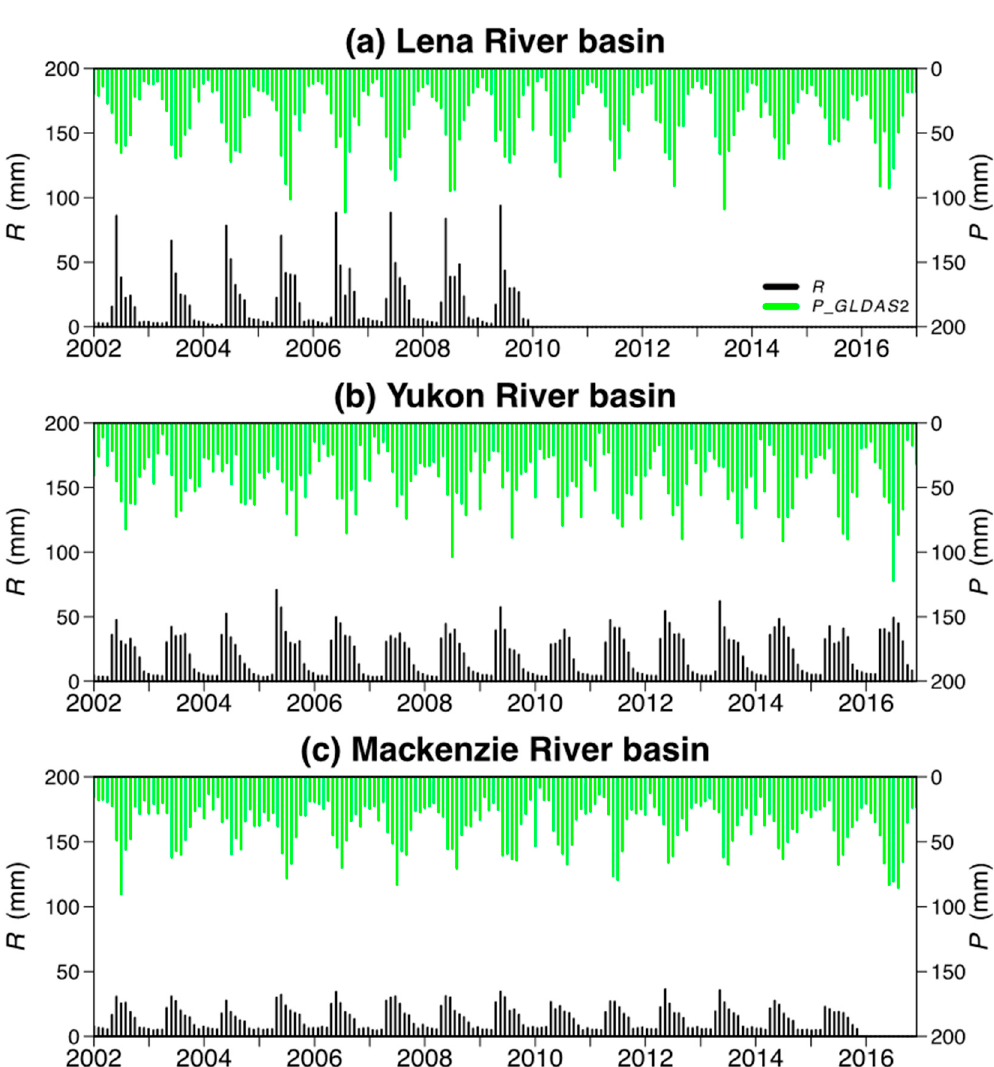
Figure 7. Temporal variations in monthly water balance components from 2002 to 2016 in the ( a ) Lena River basin, ( b ) Yukon River basin, and ( c ) Mackenzie River basin.